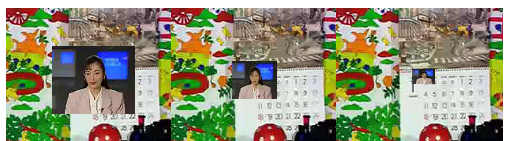
Figure 12. Mobile- Akiyo Picture in picture attack using a factor (from left to right 1/4, 1/16, 1/64) Table 3. Mean error bit rate of RDE based hashing of Key frame sequences (1, 9, 17, 25, 33, 41 and 49) under different attacks